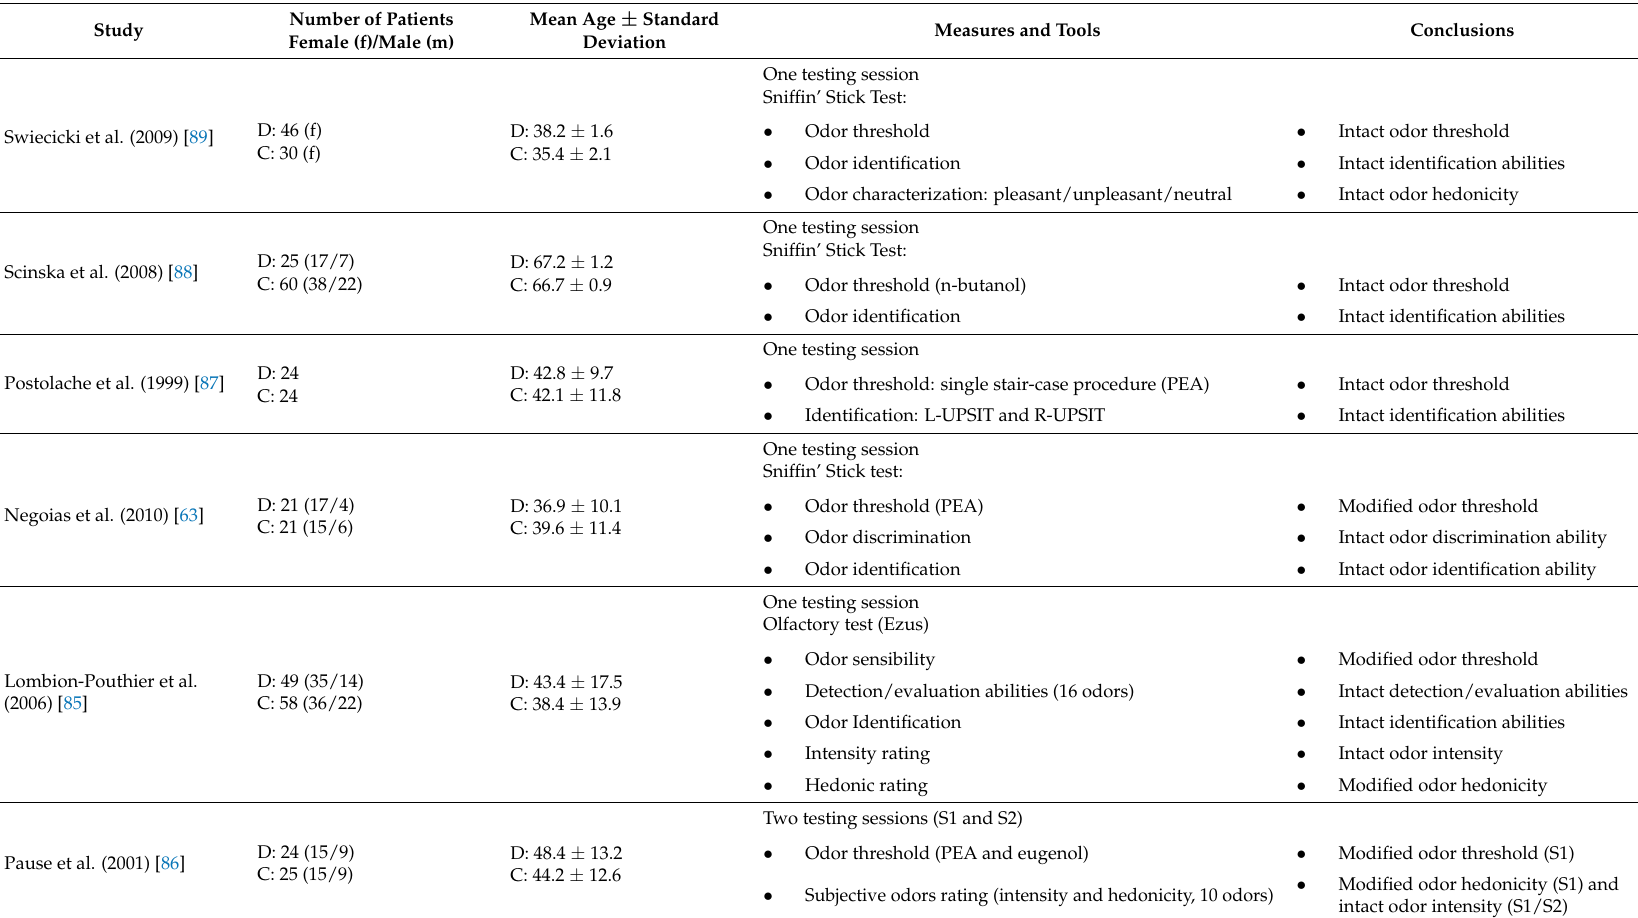
Table 2. Summary of publications on olfactory function in